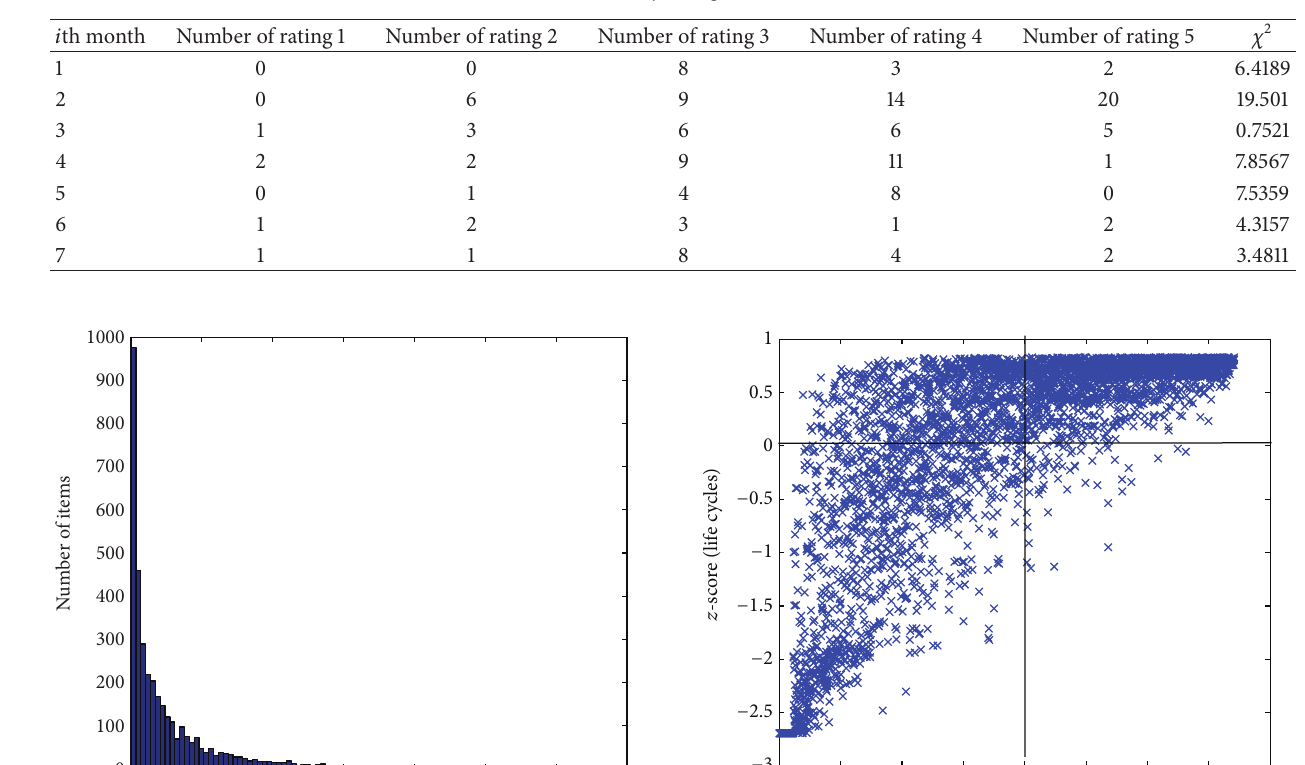
Table 3: Monthly rating distributions.